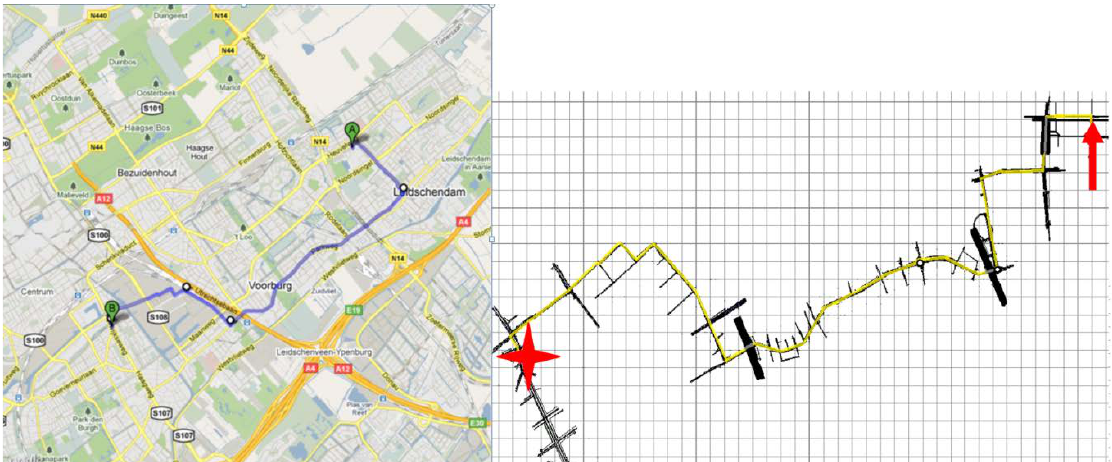
Figure 4. Two paper maps used in this study. The left map (© Google Maps) was used in the field test, and participants were instructed to drive from A to B, whereas the right map was used in the driving simulator, and participants drove from the red arrow (top right) to the red asterisk (left; both signs are enlarged for printing clarity). Note that the first two kilometre differ, which was meant for avoiding participants recognising the route immediately so they would not be engaged in way finding but in remembering the route by